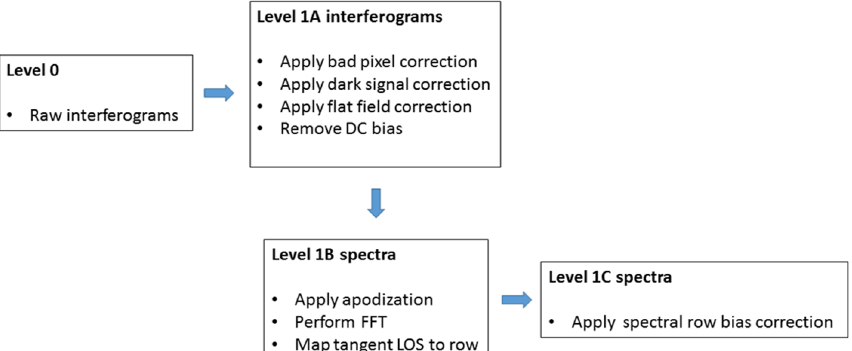
Figure 2. SHOW level 0 to level 1 processing